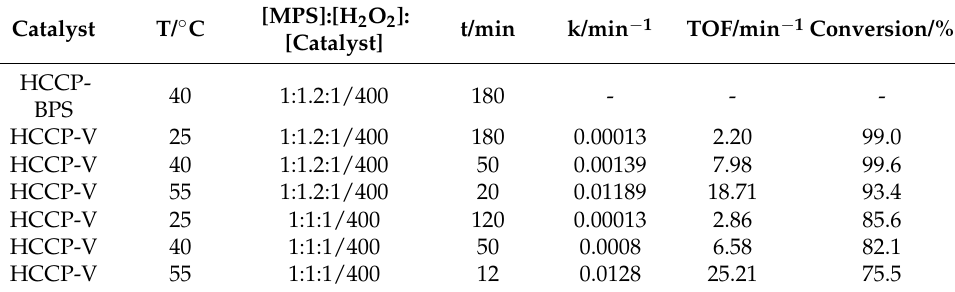
Table 1. The catalytic oxidation results of MPS by HCCP-V in CH 3 CN.